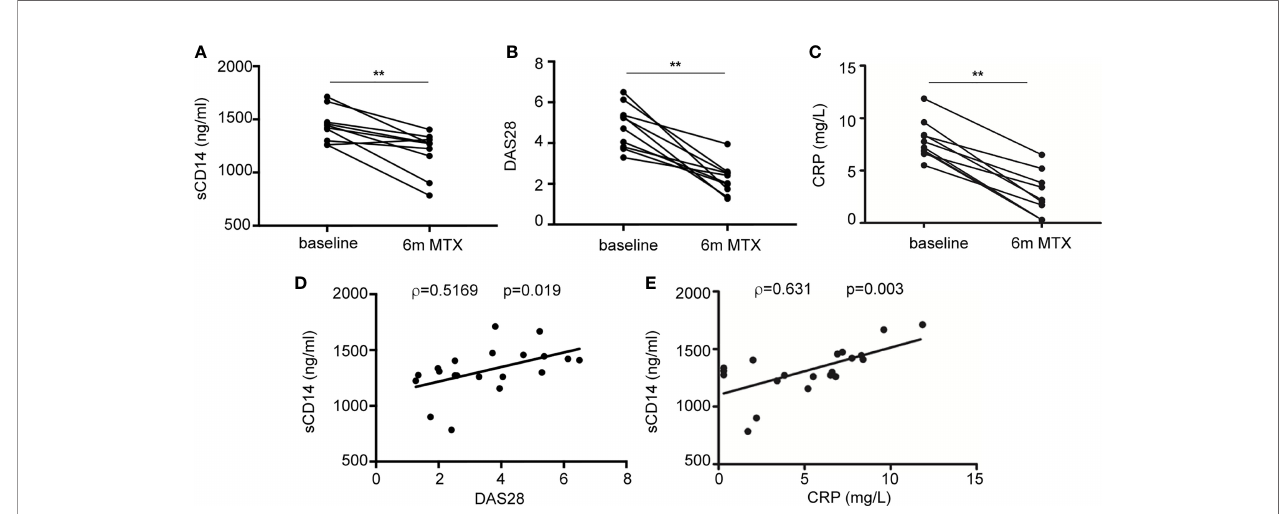
FIGURE 7 | Plasma level of sCD14 decreases in RA patients who are MTX responders. (A) sCD14 level in plasma from early RA patients at baseline and 6 months after initiating MTX treatment (15 – 25 mg/week), as determined by ELISA (n = 10, ** p < 0.01, Wilcoxon test). Disease activity score (DAS28) (B) and C-reactive protein (CRP) (C) from early RA patients at baseline and 6 months after MTX treatment from the discovery cohort. Correlation between sCD14 and DAS28 (D) sCD14 and CRP (E) in early RA patients (two-tailed Spearman ’ s correlation). RA, rheumatoid arthritis; MTX, methotrexate; sCD14, soluble CD14.